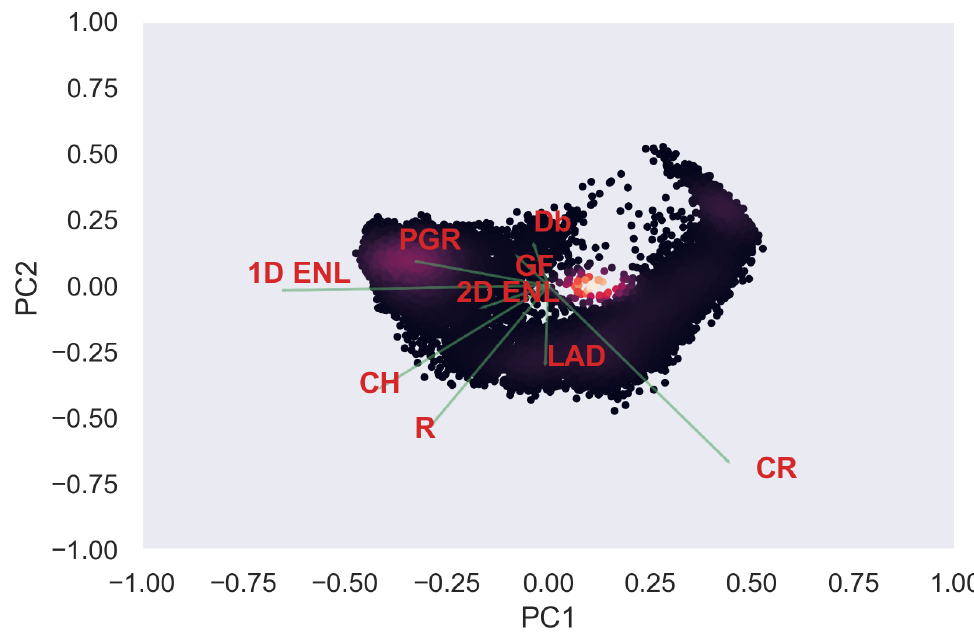
Figure A14. ULS PCA band 1 and 2 loadings at 0.5 m grid size.